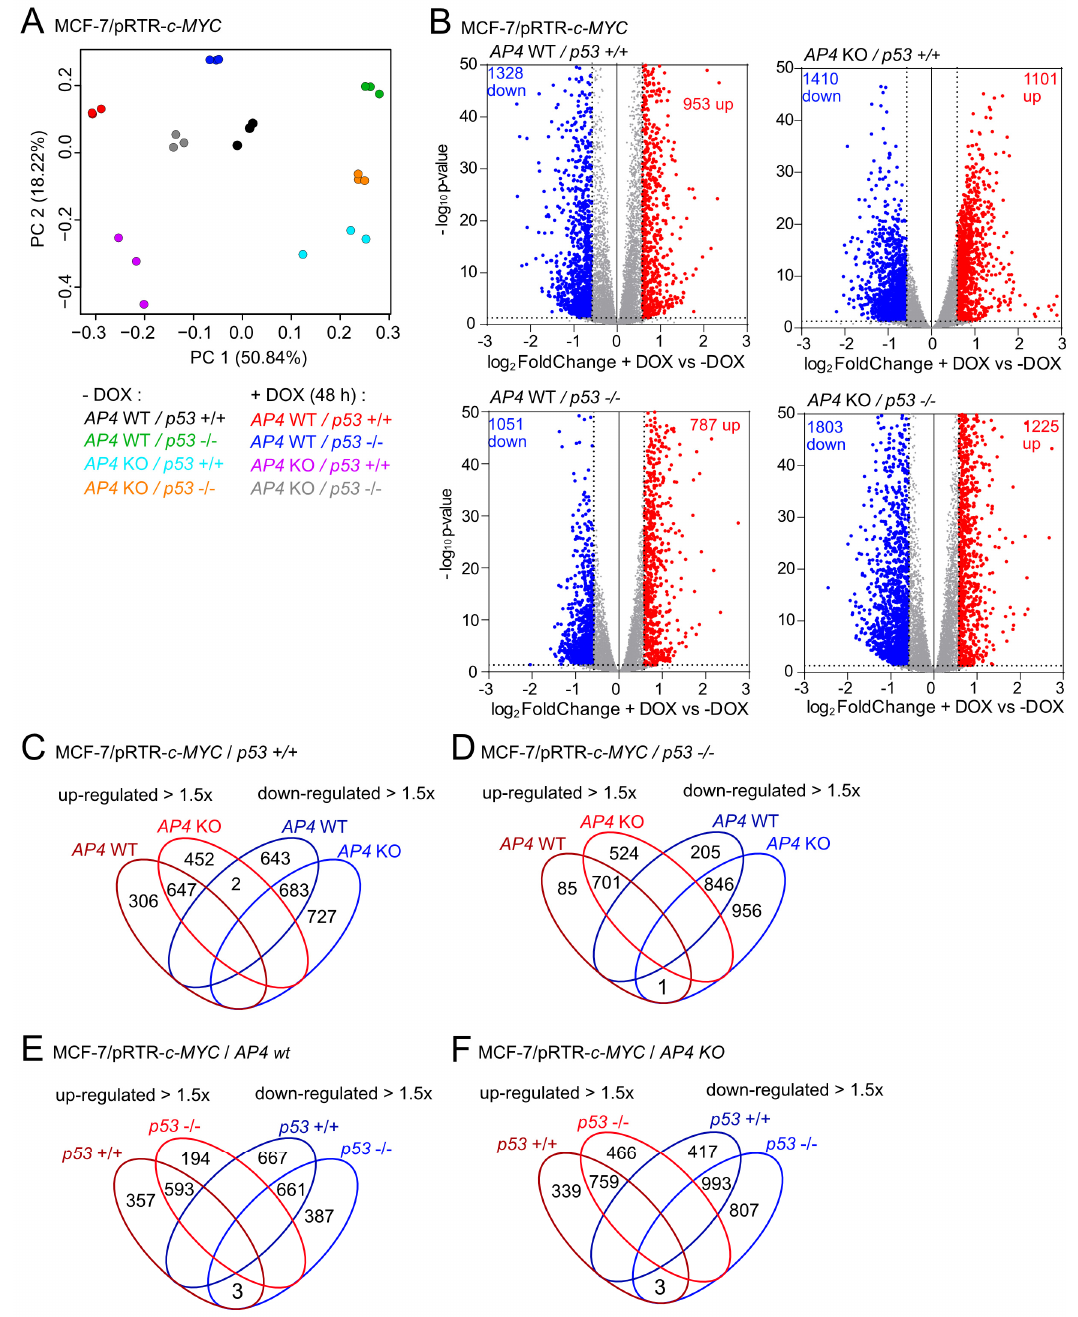
Figure 5. Transcriptional profiling of genotype-dependent and c-MYC-induced RNA expression changes in breast cancer cells. ( A ) Principal component analysis (PCA) of RNA expression in MCF-7/pRTR- c-MYC cells with the indicated genotypes and treatments. ( B ) Volcano plots showing differential RNA expression (fold changes > 1.5, FDR q -value < 0.05) between DOX-treated and untreated cells with the indicated genotypes. Significantly up- and down-regulated RNAs are highlighted as indicated. Non-significantly regulated genes are shown in gray. The numbers of differentially regulated RNAs are indicated. ( C – F ) Venn diagrams showing overlap between up- and down-regulated genes in MCF-7/pRTR- c-MYC with the indicated AP4 and p53 status after induction of c- MYC with